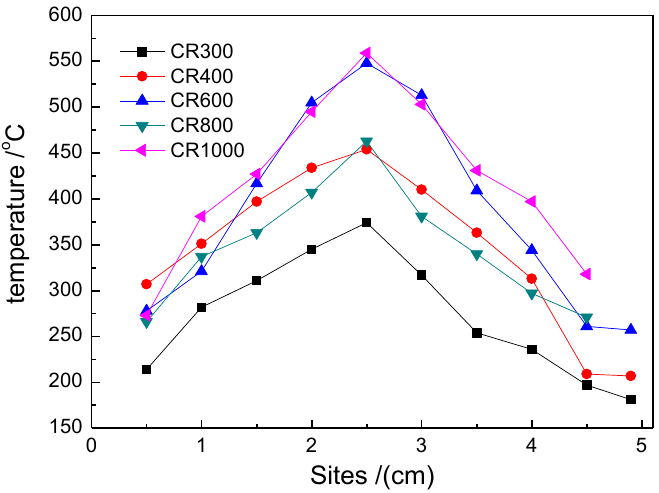
Figure 5. Temperature variation of the catalyst disc surface under different concentrating ratios. Conditions: 0.1 MPa CO 2 , 0.5 mL H 2 O, room temperature at about 20 °C, measured at noon.